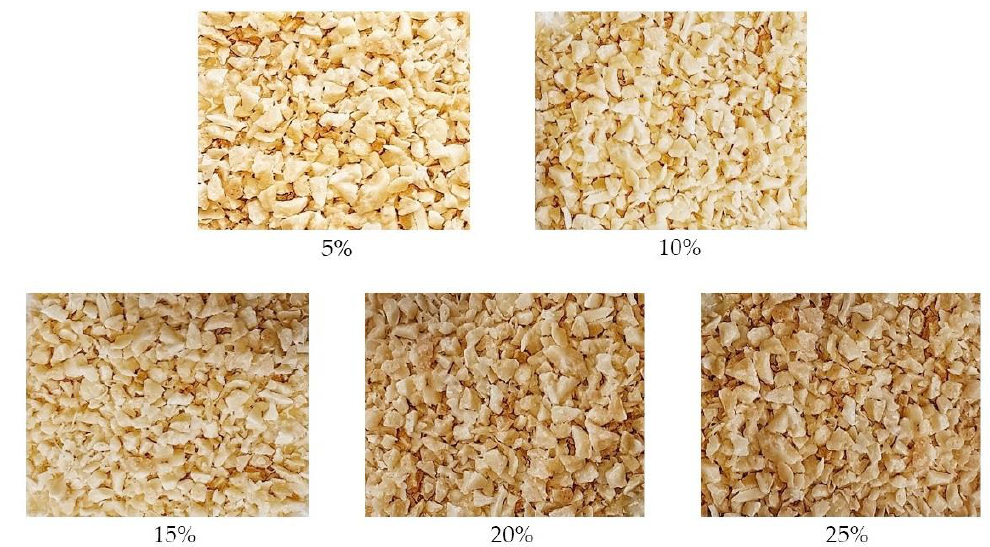
Figure 6. Cellulose pulp composites pellets indicating their respective cellulose composition prepared from Gelimat mixer and later pelletized prior to injection.